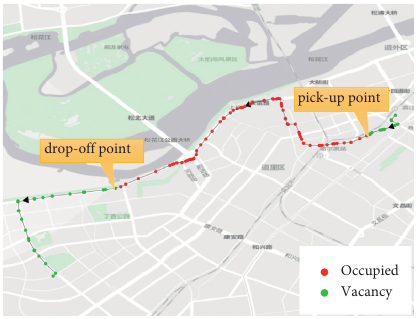
Figure 3: A piece of continuous trajectory of a